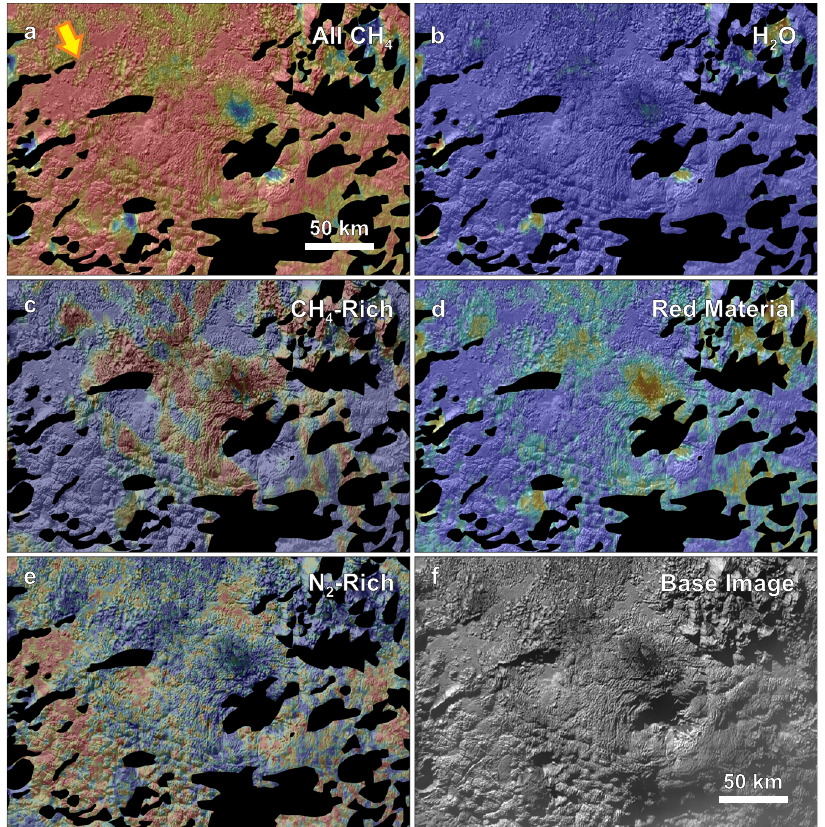
Fig. 2 Surface composition of the Wright Mons region. Color-scale composition maps from ref. 41 derived from LEISA spectral data (see Supplementary Table 1) overlain on a greyscale panchromatic basemap. In all panels, redder colors indicate a greater absorption/band depth or a greater spectral index, indicating a stronger presence of the material. The range of values for each index is given in this caption. a , methane (CH 4 ) band depth (with values from − 0.08 to 0.43) wherever this molecule appears (as CH − 1.14 to 0.93), 4 -rich ice or in N 2 -rich ice), b , water ice spectral index (H 2 O) (with values from c , areas where methane dominates over nitrogen ice (CH 4 -rich only, found generally at higher elevations; with values of the 'CH 4 bands position index ’ from 39 to 47; see ref. 41 their Fig. 22), d , an organic dark, red (in the visible) material index (with values from − 1.94 to − 0.18), e , areas where nitrogen ice (N 2 ) dominates over methane (with values of the ‘ CH 4 bands position index ’ from 42 to 32), and f , the panchromatic basemap alone. Please note that the shadowed regions have been excluded here because the low light levels make them dif fi cult to accurately characterize with the LEISA data. The data is shown in a simple cylindrical map projection. The longitude and latitude extents of the image are ~164 – 179°E and ~16 – 25°S. The large arrow in the upper left indicates the approximate direction of the incoming light. Methane dominates much of the region but water ice (mixed with dark red material) is apparent on dark/low albedo patches, which are presumably warmer areas where methane ice is not